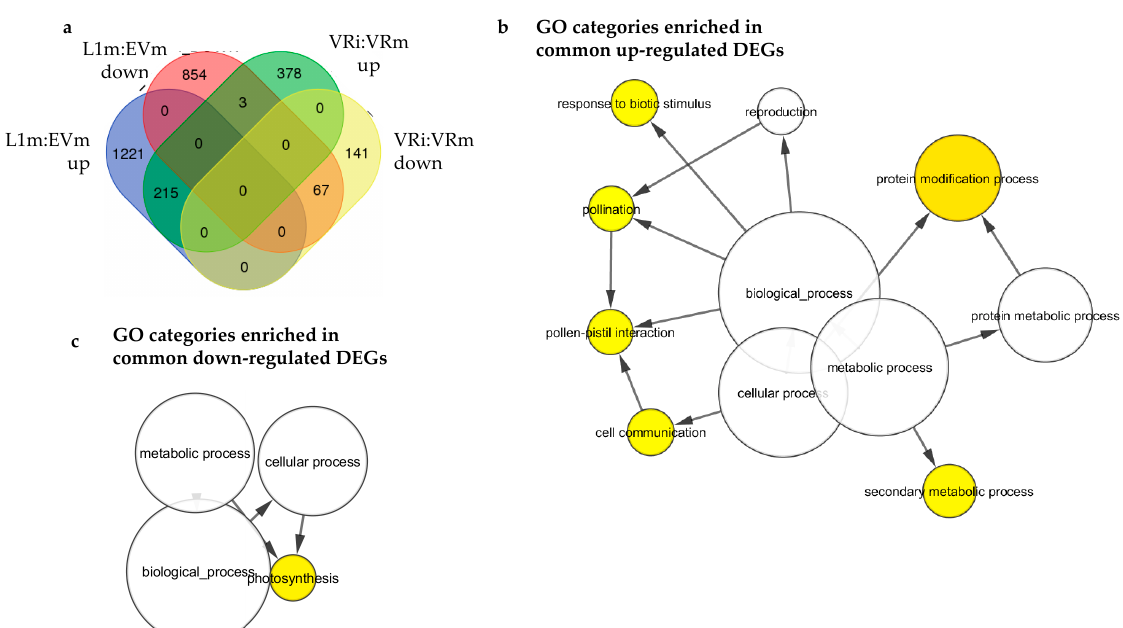
Figure 8. Comparison of differentially expressed genes at the basal level in mock-infected transgenic plants expressing VviATL156 (L1m) compared to empty vector controls (EVm) and genes that are modulated in Vitis riparia following infection with P. viticola (VRi vs. VRm). ( a ) Venn diagram showing differentially expressed genes between mock-infected transgenic and control plants (L1m vs. EVm) and infected vs. non-infected Vitis riparia (VRi vs. VRm) from Polesani et al. (2010). ( b ) BINGO enrichment analysis of upregulated genes in the above comparisons. ( c ) BINGO enrichment analysis of downregulated genes in the above comparisons. The size of the nodes is proportional to the number of genes in the test set which are annotated to that node, while the color of the node represents the corrected p-value. The node color scale ranges from white (not significantly over-represented) to yellow ( p -value < 0.05).